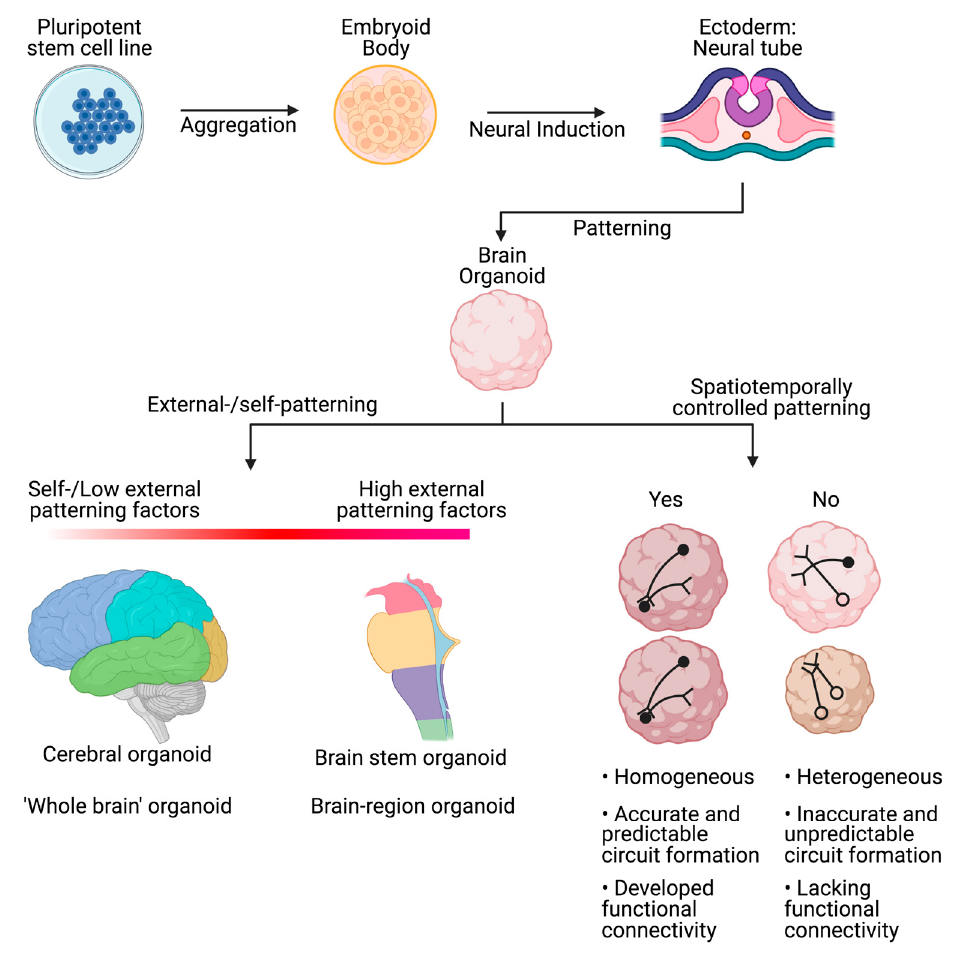
Figure 2. Schematic overview of the differentiation progress of organoids with patterning factors. Outcome differences between the use of high or low concentrations of patterning factors and the spatiotemporal control of